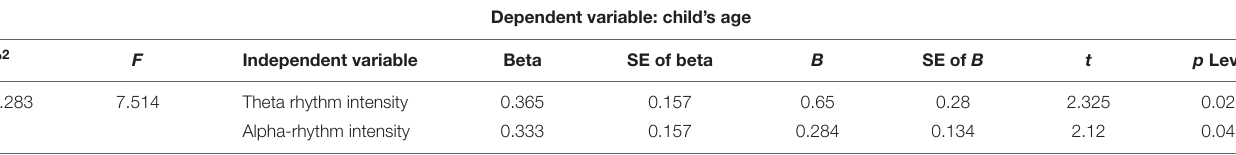
TABLE 4 | Result of multiple regression analysis: EEG characteristics—intensity of theta and alpha rhythms/child’s age (4–6